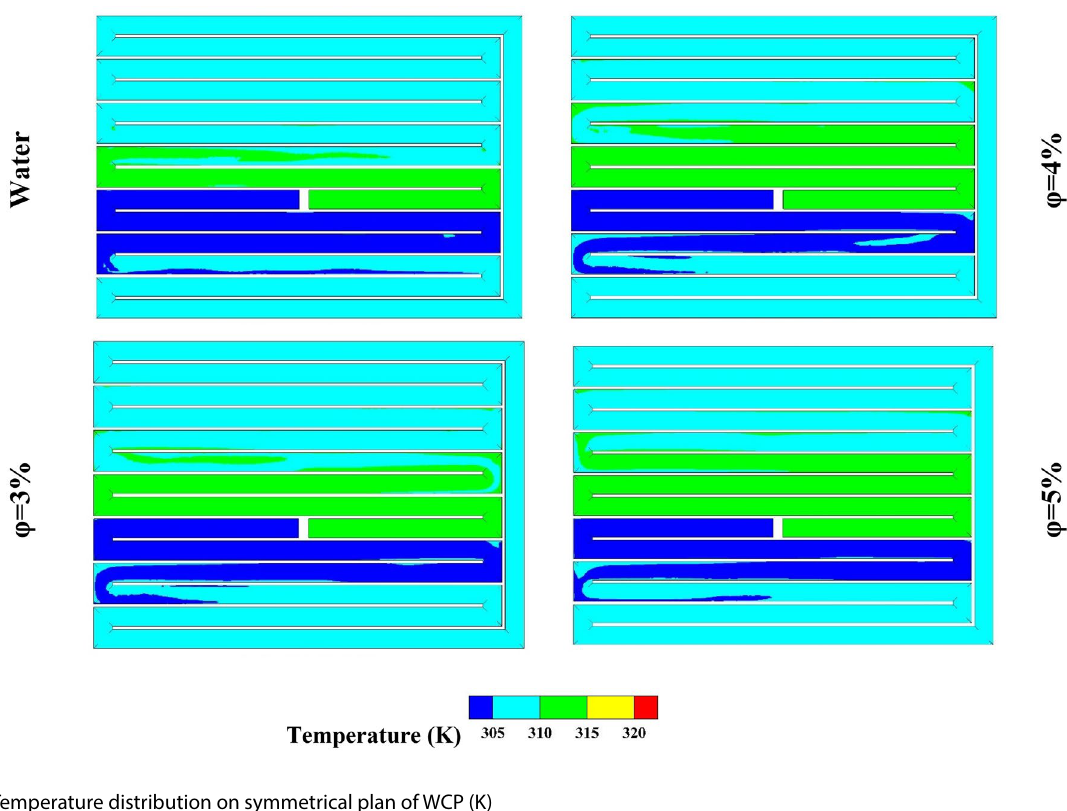
Fig. 23 Temperature distribution on symmetrical plan of WCP (K)